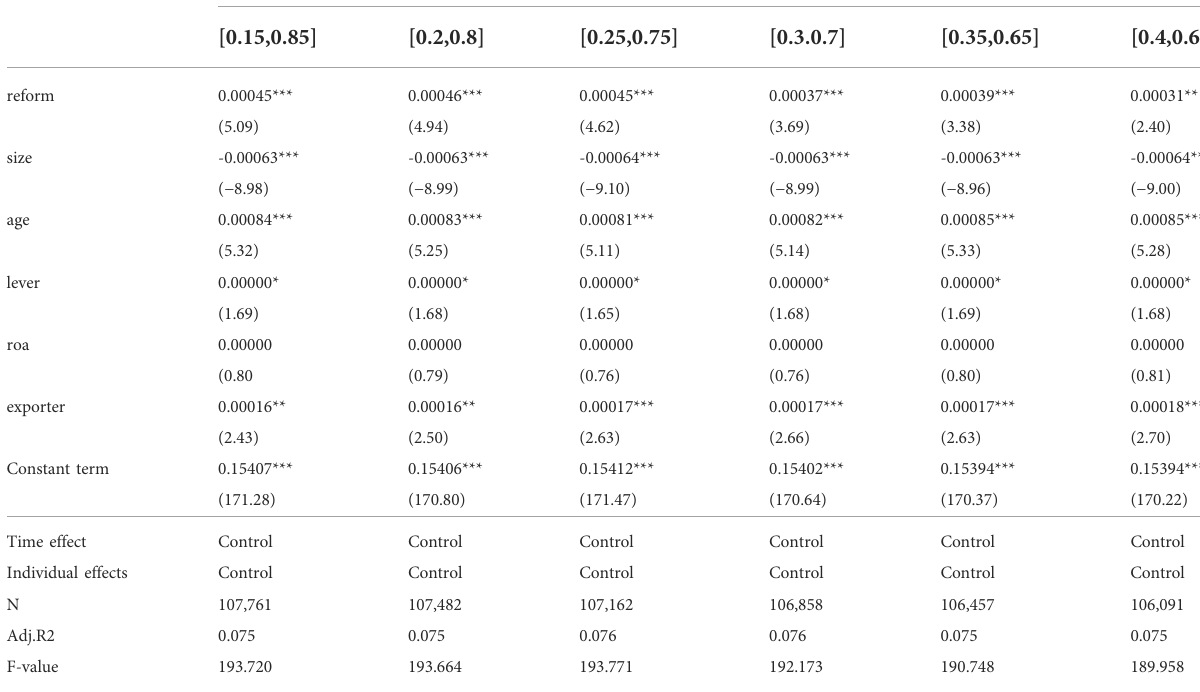
TABLE 4 Breakdown of the impact of mixed ownership reform on SOEs ’ innovation.